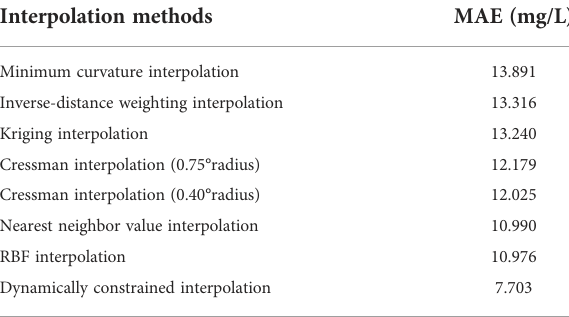
TABLE 3 Cross-validation results of eight interpolation